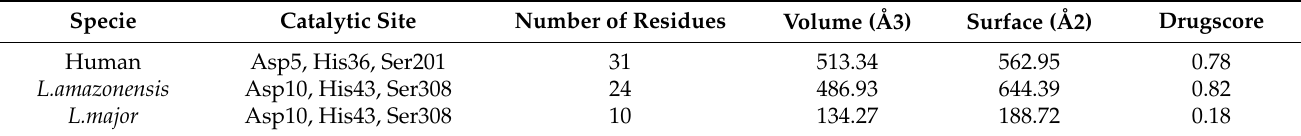
Table 1. Residues involved in the binding site of the human and Leishmania subtilisin S8